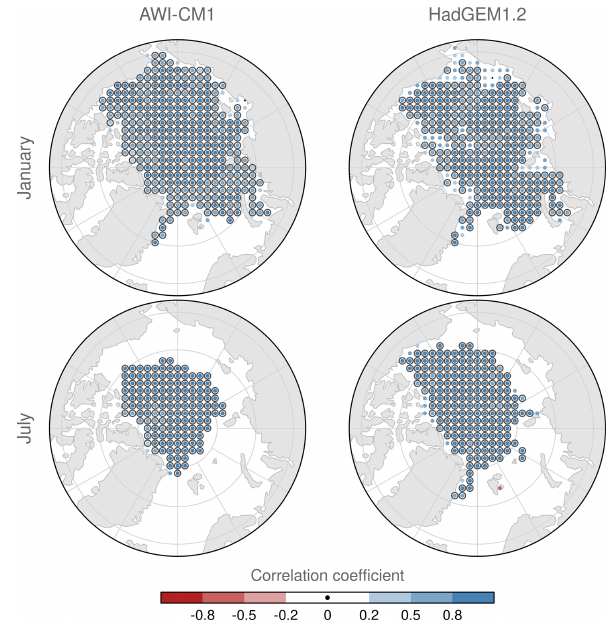
Figure B4. Maps of the correlation coefficient of the normalized uncertainties in Eulerian ice drift and near-surface wind vectors at t = 12d lead time (colored dots), using the different initializations (at least eight) as the sample. Locations with p < 0 . 05 are marked with a black ring; locations with a correlation weaker than ± 0 . 2 are denoted by a small black dot. There is a strong and significant pos- itive correlation of sea ice drift uncertainty and near-surface wind vector